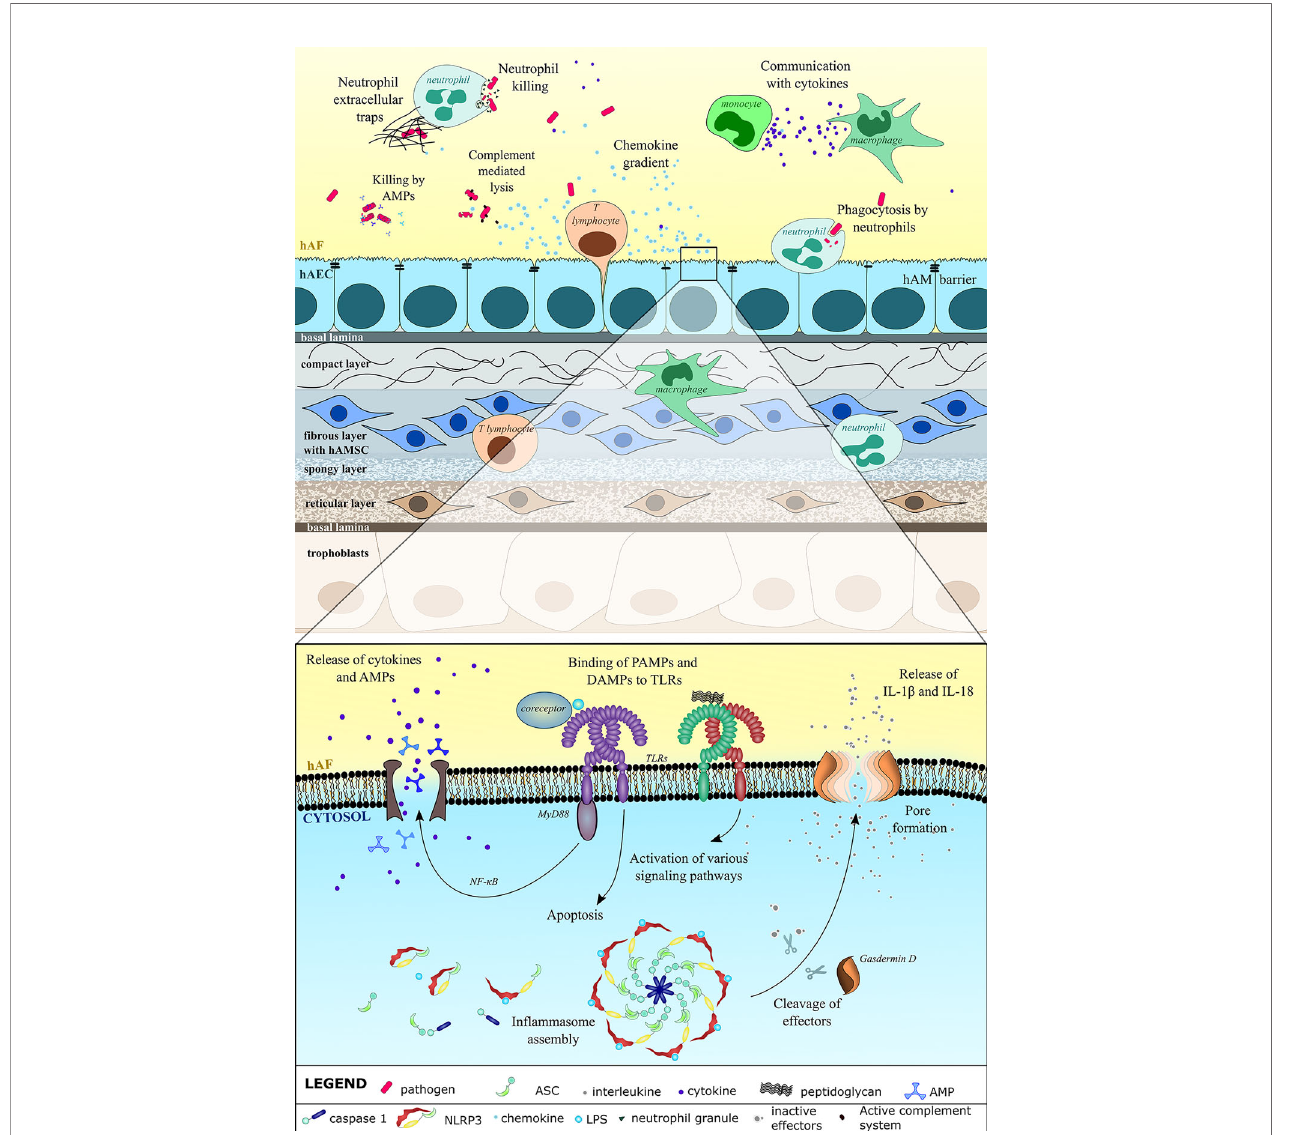
FIGURE 1 | Innate immune system defense against pathogens in the hAF and hAM is comprehensive. hAM integrity prevents the entry of pathogens. Breaching of hAM causes upregulated expression and release of cytokines, including chemokines, which engage immune cells neutrophils, macrophages, monocytes and T lymphocytes. Immune cells regulate the in fl ammatory process and directly kill the microbes through phagocytosis, formation of neutrophil extracellular traps, and direct killing with granules. Using the pattern recognition receptors (PRRs), the hAEC recognize the pathogen-associated molecular patterns (PAMPs) (LPS, bacterial glycoprotein) and damage-associated molecular patterns (DAMPs) that are a result of the microbial infection. Most notably, these include toll-like receptors (TLRs) on cell membrane and the nucleotide-binding oligomerization domain (NOD)- Leucin Rich Repeats (LRR)-containing receptors (NLRs) in the cytosol, both of which induce various downstream signaling that culminates in the release and maturation of in fl ammatory cytokines, regulated cell death and secretion of antimicrobial peptides (AMPs). AMPs and activated complement system directly damage pathogens, mainly by targeting their cell wall and by causing